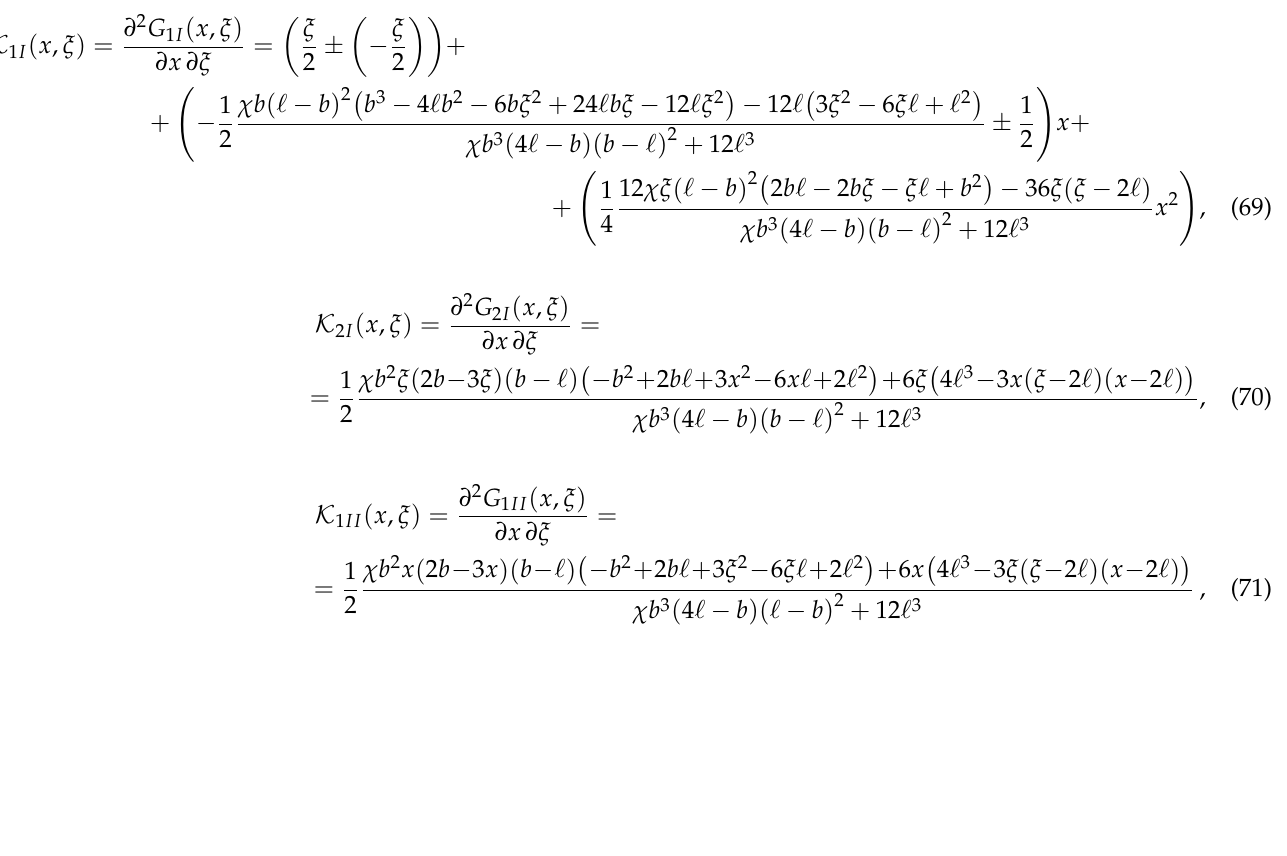
A comparison of Equations (54)–(57), (63) and (64) yields the elements of the kernel function for FssP